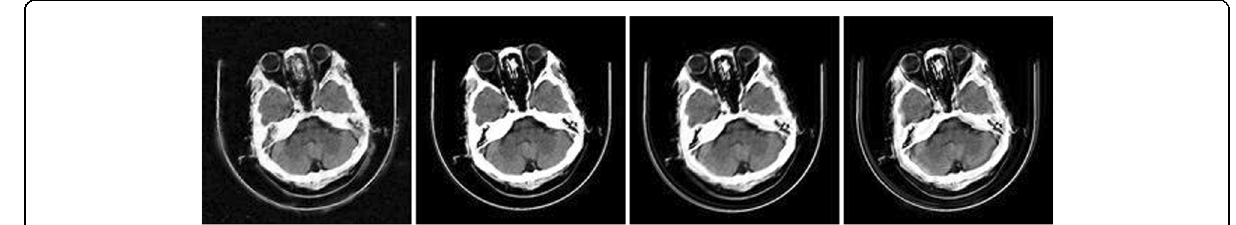
Fig. 8 Comparison of reconstructed images with different reconstruction methods (head